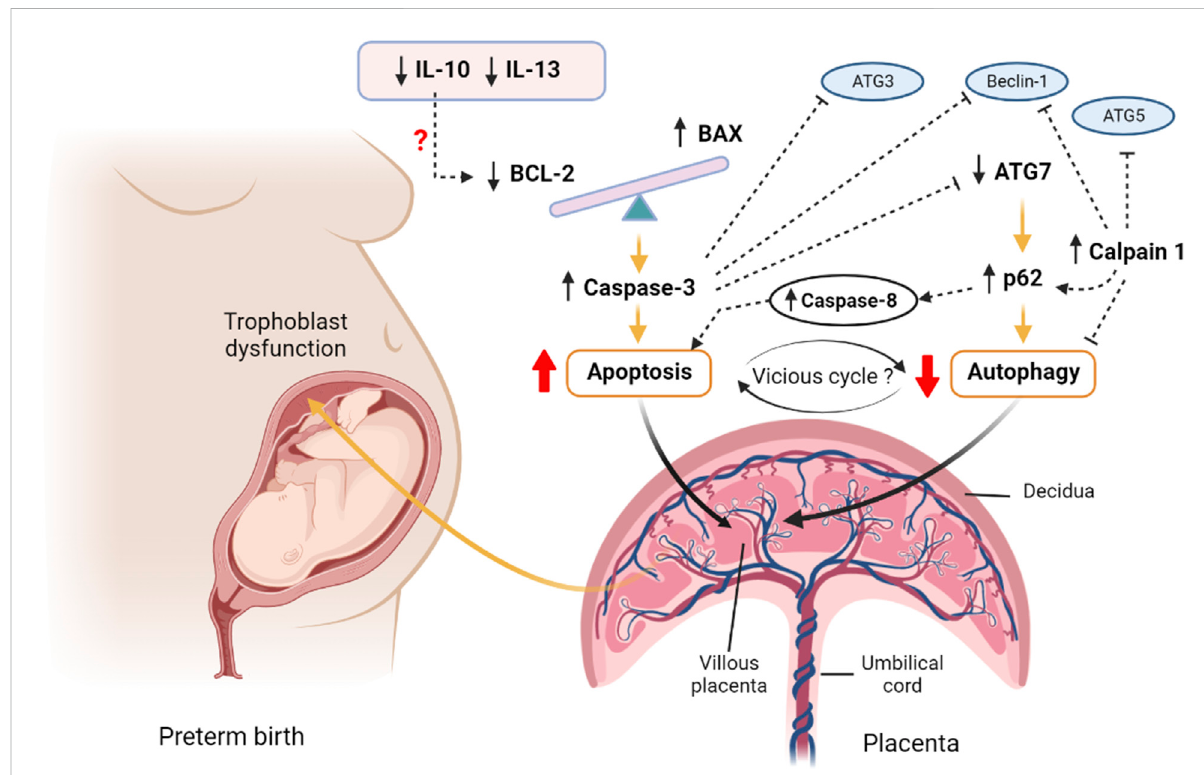
FIGURE 5 A proposed hypothesis of apoptosis and autophagy interactions in preterm birth. The imbalanced BAX/BCL2 expression in the preterm villous placenta increases the release of Caspase 3 and augments intrinsic pathway of apoptosis. The upstream downregulation of IL10 may potentiate downregulation of BCL2 expression leading to BAX/BCL2 imbalance. Caspase 8 is also activated as an indicator of potential extrinsic apoptotic pathway activation. On the other hand, the downregulation of autophagy gene ATG7 results in accumulation of p62 cargo protein within the villous tissue which inhibits the net autophagy fl ux. The high level of p62 favours accumulation of effector caspases, including Caspase 8 and executesapoptosis.The aggregation ofcaspases includingCaspase3degradesessential autophagy-associated proteins,suchas Beclin1,ATG3 and ATG7, which consequently inhibits autophagy. Calpain 1 cleaves ATG5 and Beclin 1 and facilitates accumulation of p62 resulting in net inhibition of autophagy fl ux. Thus, a vicious cycle may potentially be established between apoptosis and autophagy via the reciprocal stimulatory actions of caspases and p62 within the preterm villous placenta that may have a pathognomonic effect on PTB. The fi gure is created with